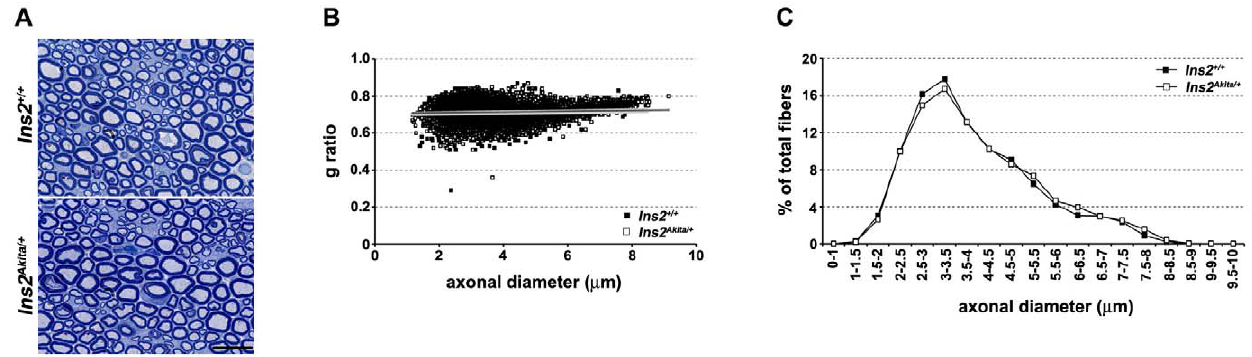
Figure 3. Morphometric evaluation of peripheral nervous system of Ins2 Akita// + mice. A ) Semi-thin toluidin blue stained cross sections of sciatic nerves from three months old Ins2 Akita/ + and control mice show well preserved nerve structures in both genotypes (scale bar: 15 m m). B ) The scatter plot displays g ratios (g ratio=axon area/axon + myelin area) of individual axons as a function of the respective axonal diameters determined using sciatic nerves of three month old wild-type and Ins2 Akita/ + mice. Each point corresponds to one fiber. Thin dark-grey and thick light-grey lines represent the trend-lines for Ins2 Akita/ + and wild-type mice respectively. The two lines are superimposed reflecting close similarity of the two data sets. C ) Axonal distribution represented as the percentage of axons for each class of sizes does not reveal any differences between wild-type and Ins2 Akita/ + mice.